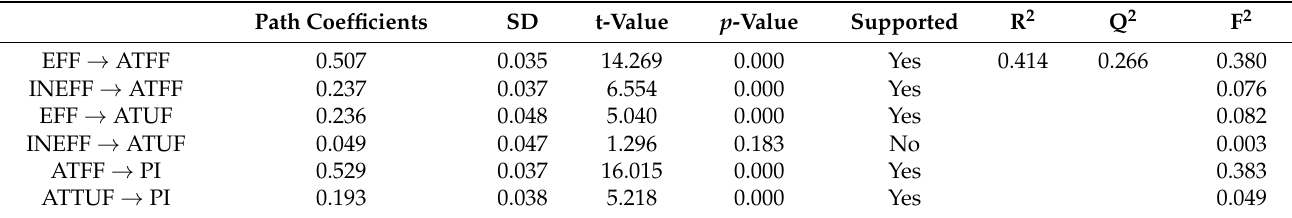
Table 5. Hypothesis testing (structure model results).